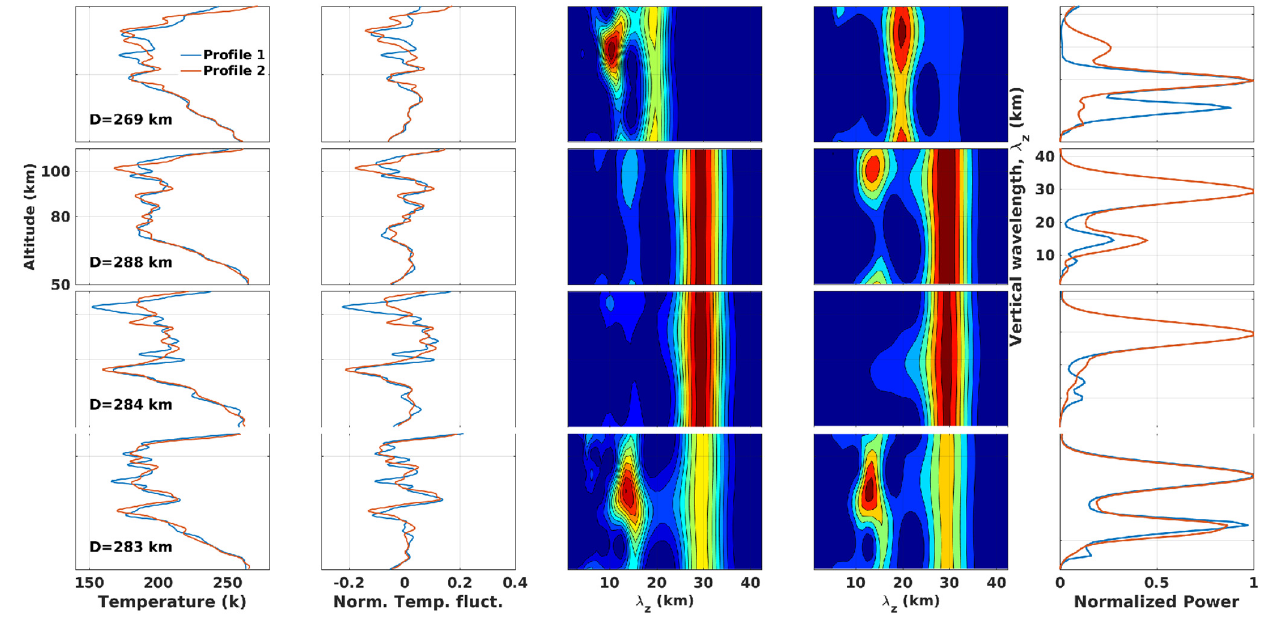
Figure 5. temperature profiles ( left panels ), normalized temperature fluctuations ( 2nd column from the left ), contour maps of WPS versus vertical wavelength and altitude for the two profiles ( 3rd and 4th columns from the left , deep red and blue colors represent respectively the dominant and lowest power), and normalized GWPS versus vertical wavelength ( right column ) corresponding to six or- bits of SABER satellite on 16 October 2011.